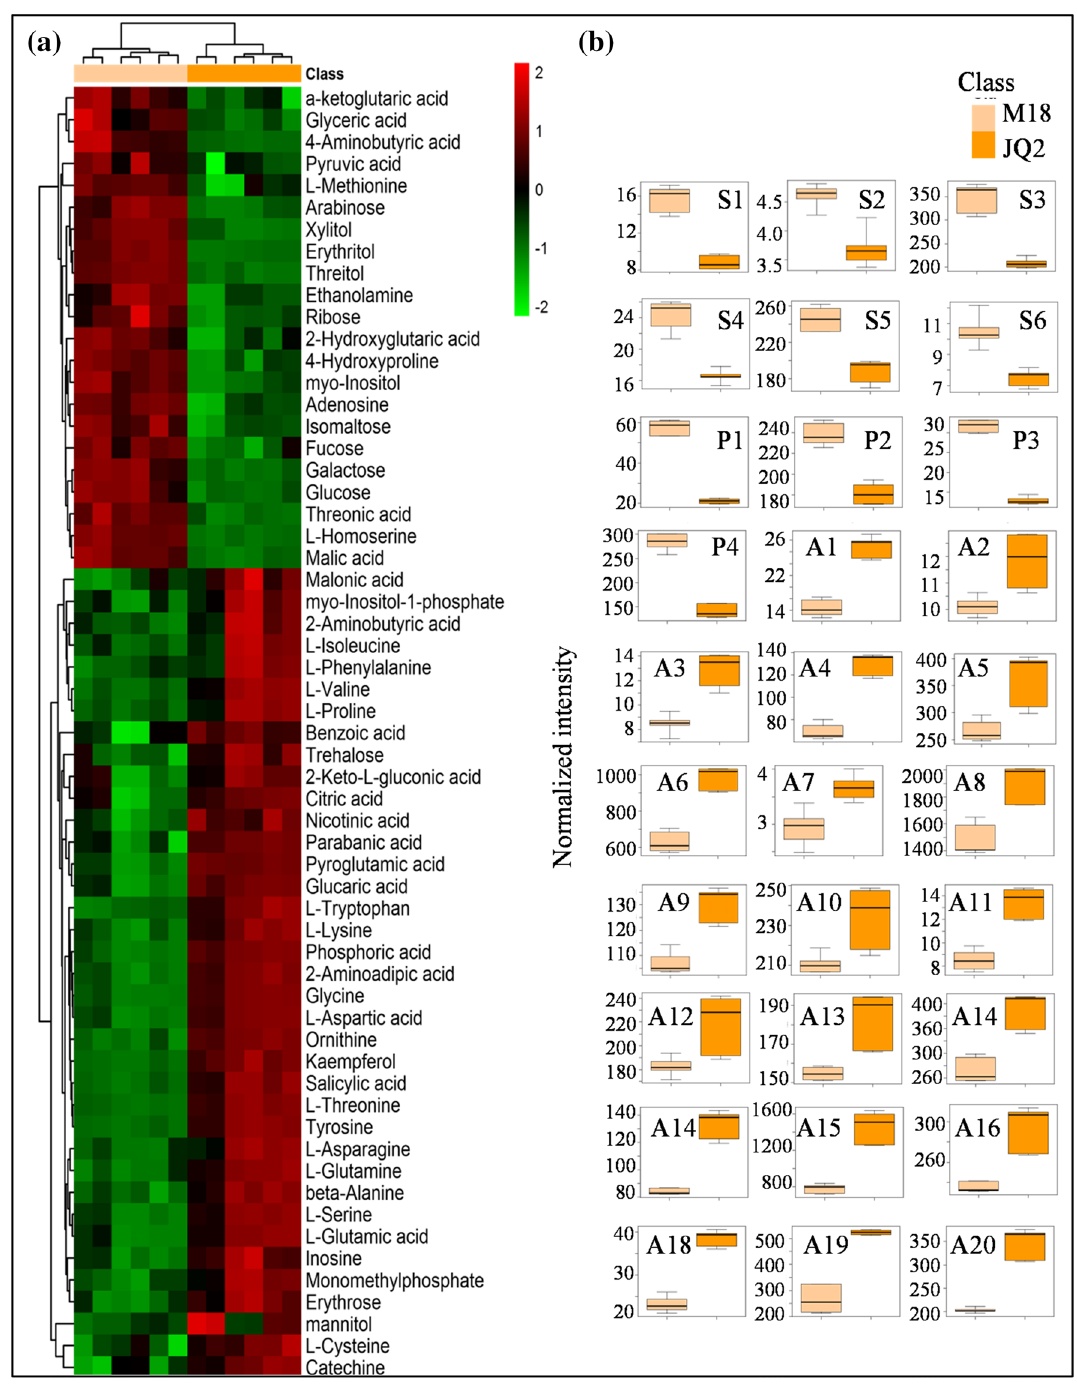
Figure 4. The heatmap ( a ) of DEMs and the boxplot-visualizations of partial DEMs ( b ) by GC–MS. The scale of data set and the bidirectional clustering of samples and metabolites by hierarchical clustering were performed using the pheatmap package in R (V1.0.8). S1 indicates arabinose, S2 indicates fucose, S3 indicates galactose, S4 indicates glucose, S5 indicates isomaltose, S6 indicates ribose, P1 indicates erythritol, P2 indicates myo-inositol, P3 indicates threitol, P4 indicates xylitol, A1 indicates 2-aminoadiopic acid, A2 indicates 2-aminobutyric acid, A3 indicates beta-Alanine, A4 indicates glycine, A5 indicates l-asparagine, A6 indicates l-aspartic acid, A7 indicates l-cysteine, A8 indicates l-glutamic acid, A9 indicates l-glutamine, A10 indicates l-isoleucine, A11 indicates l-lysine, A12 indicates l-phenylalanine, A13 indicates l-proline, A14 indicates l-serine, A15 indicates l-threonine, A16 indicates l-tryptophan, A17 indicates l-valine, A18 indicates ornithine, A19 indicates pyroglutamic acid, A20 indicates tyrosine. (n =